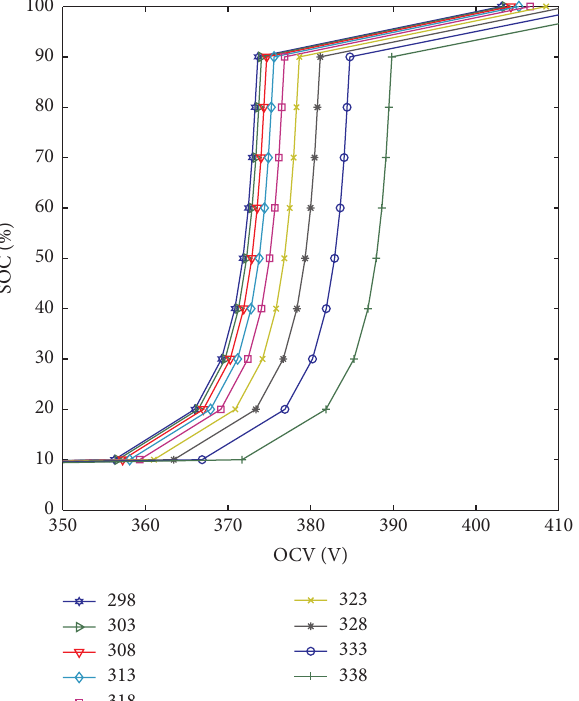
Figure 5: SOC versus OCV at different